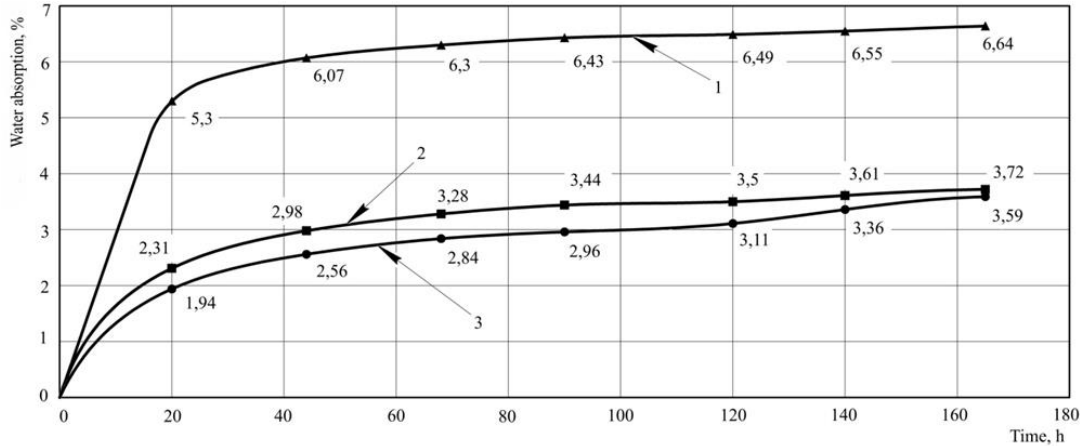
Figure 5. Decrease in speed and capacity of water vapour sorption during storage of gypsum binder under 100 % relative humidity; 1: control sample; 2: with 0.5 % additive (bog peat); 3 with 1 % additive (bog peat).